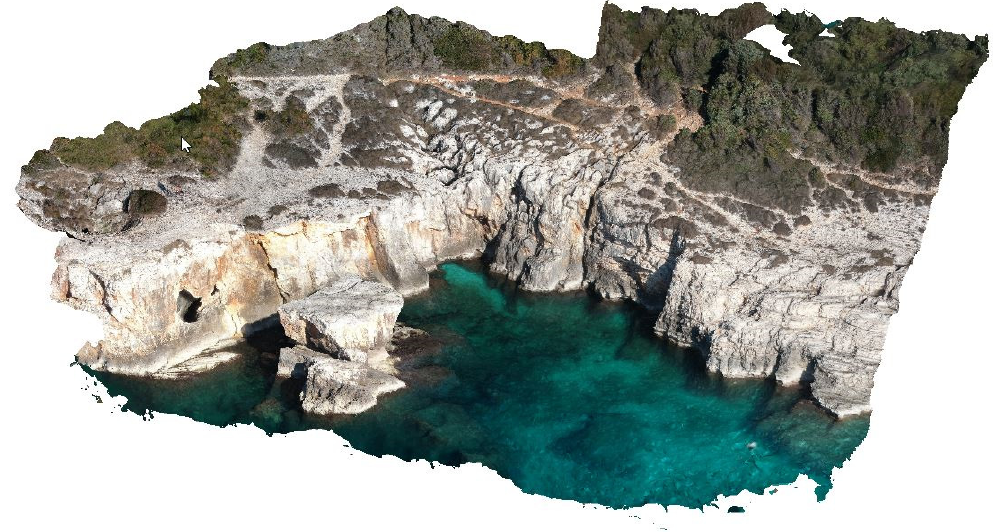
Remote Sens. 2020 , 12 , 1880 Figure 13. Textured model of site 2 with drone images. Figure 13. Textured model of site 2 with drone images.